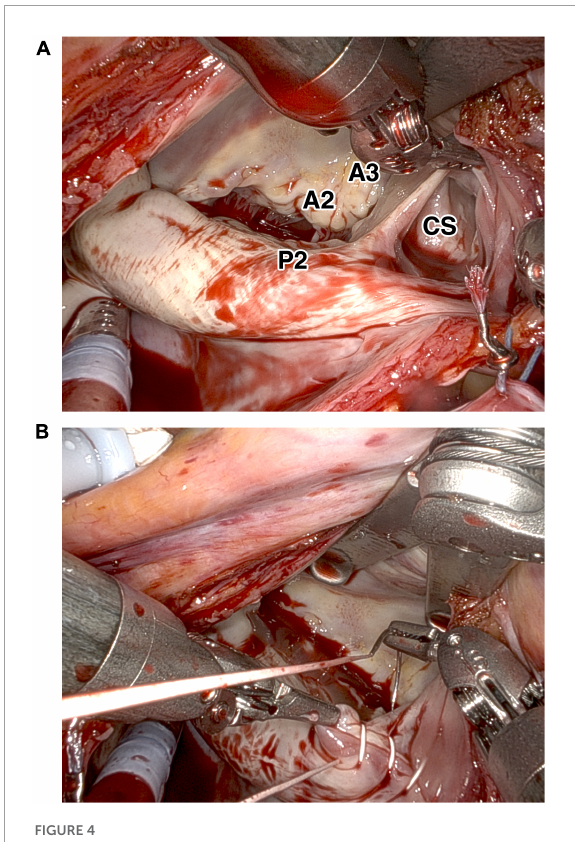
FIGURE4 Intraoperative findings of the unroofed coronary